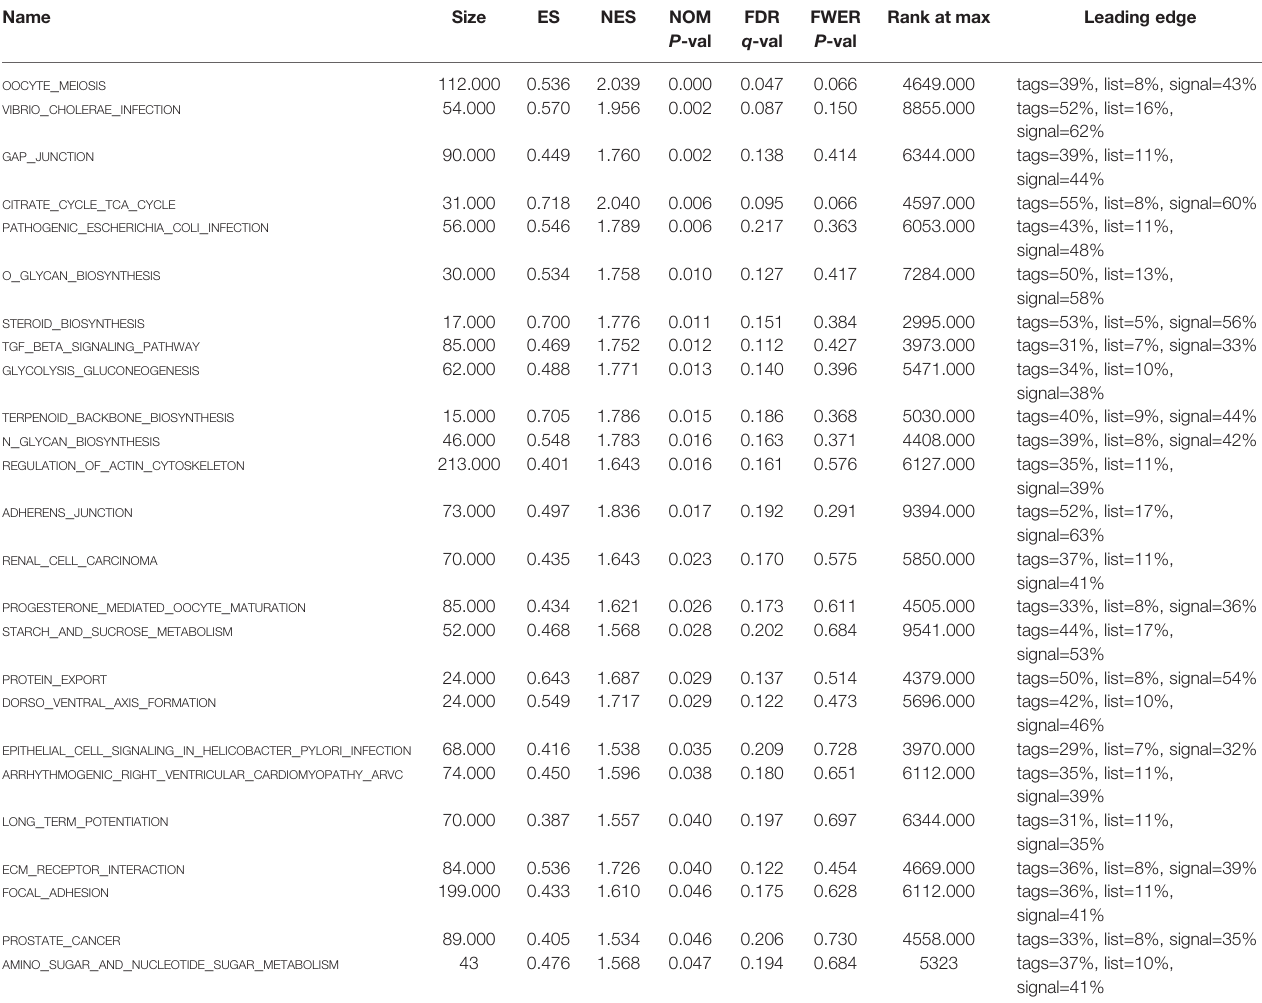
TABLE 6 | Gene set enrichment analysis based on the signature of 9 autophagy-related